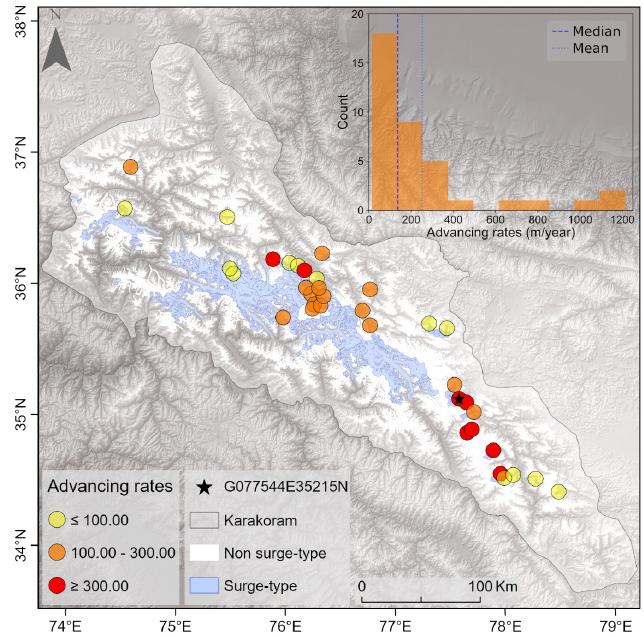
Figure 10. Spatial variation in the terminus – advancing rates of the 38 clean ‐ ice or partly debris ‐ covered glacier ‐ surging events. The upper right inset shows the statistics of the terminus – advancing rates of the surge ‐ type glaciers.